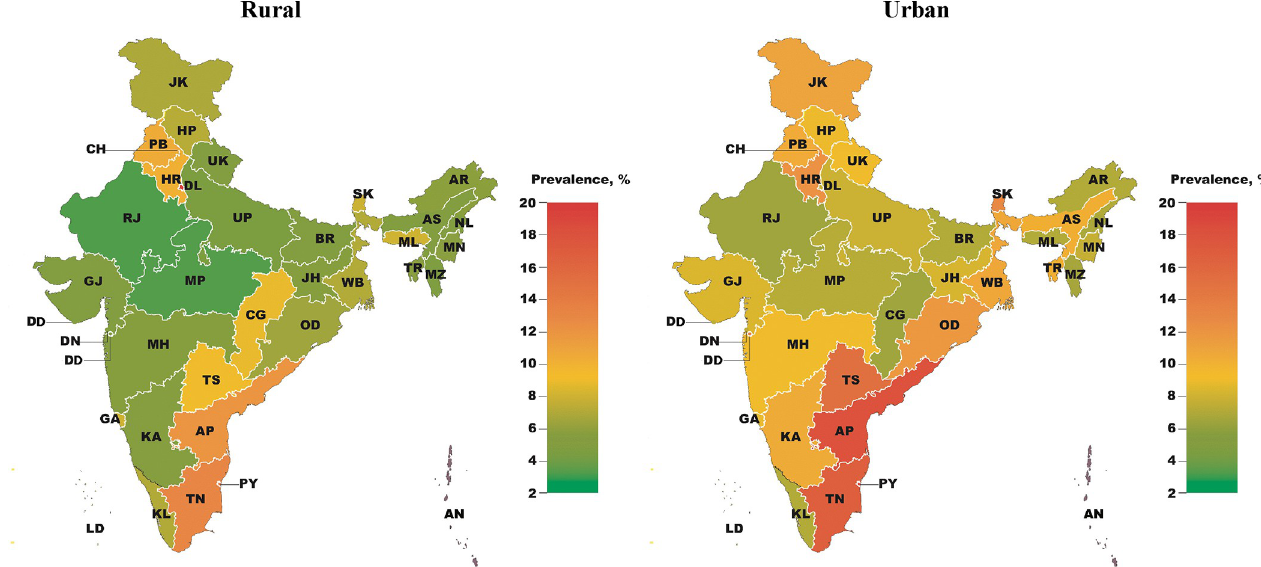
Fig 3. Age-standardized prevalence of multimorbidity by state and rural vs urban location 1,2,3 . 1 Point estimates and 95% CIs for each state and union territory can be found in S5 Table . 2 AN indicates Andaman and Nicobar Islands; AP, Andhra Pradesh; AR, Arunachal Pradesh; AS, Assam; BR, Bihar; CG, Chhattisgarh; CH, Chandigarh; DN, Dadra and Nagar Haveli; DL, Delhi; DD, Daman and Diu; GA, Goa; GJ, Gujarat; HR, Haryana; HP, Himachal Pradesh; JH, Jharkhand; JK, Jammu and Kashmir; KA, Karnataka; KL, Kerala; LD, Lakshadweep; MP, Madhya Pradesh; MH, Maharashtra; MN, Manipur; ML, Meghalaya; MZ, Mizoram; NL, Nagaland; OD, Odisha (Orissa); PB, Punjab; PY, Puducherry; RJ, Rajasthan; SK, Sikkim; TN, Tamil Nadu; TS, Telangana State; TR, Tripura; UP, Uttar Pradesh; UK, Uttarakhand (Uttaranchal); WB, West Bengal. 3 The map used for this figure was sourced from Survey of India, the national survey and mapping organization of India, Department of Science & Technology, Government of India.